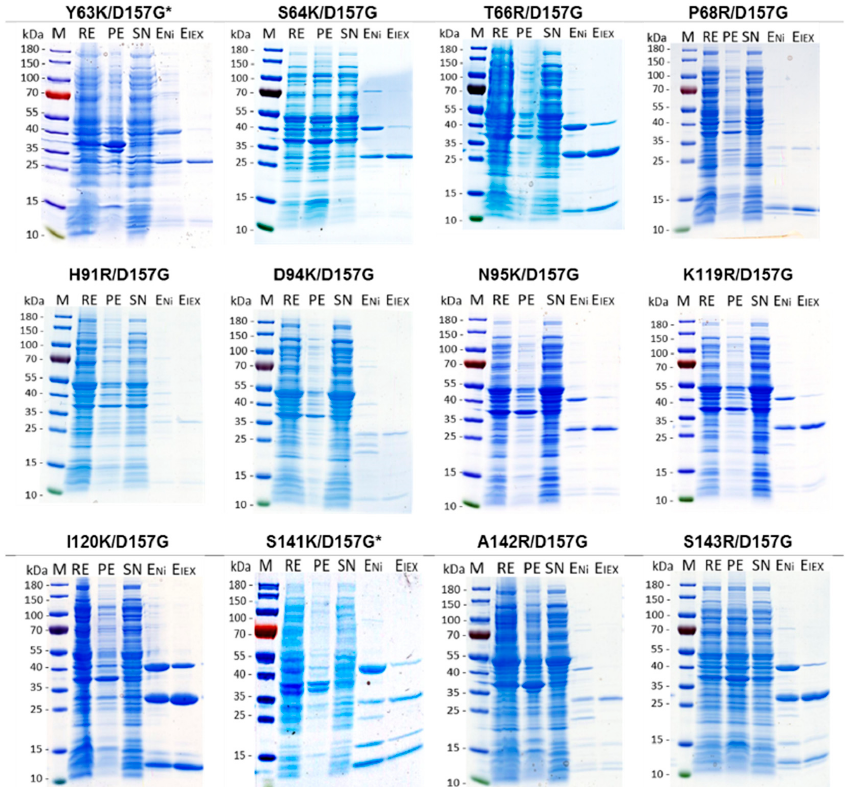
Figure A2. SDS-PAGE results illustrating the purification of all mutant enzymes. M—protein marker, RE—crude extract, PE—pellet, SN—supernatant, E Ni —elution fraction Ni-agarose, E IEX —elution fraction ion exchange chromatography. Asterisks (*) indicate that inactive mutants Y63K/D157G and S141K / D157G were purified using non-optimized gravity flow purification approaches, resulting in lower